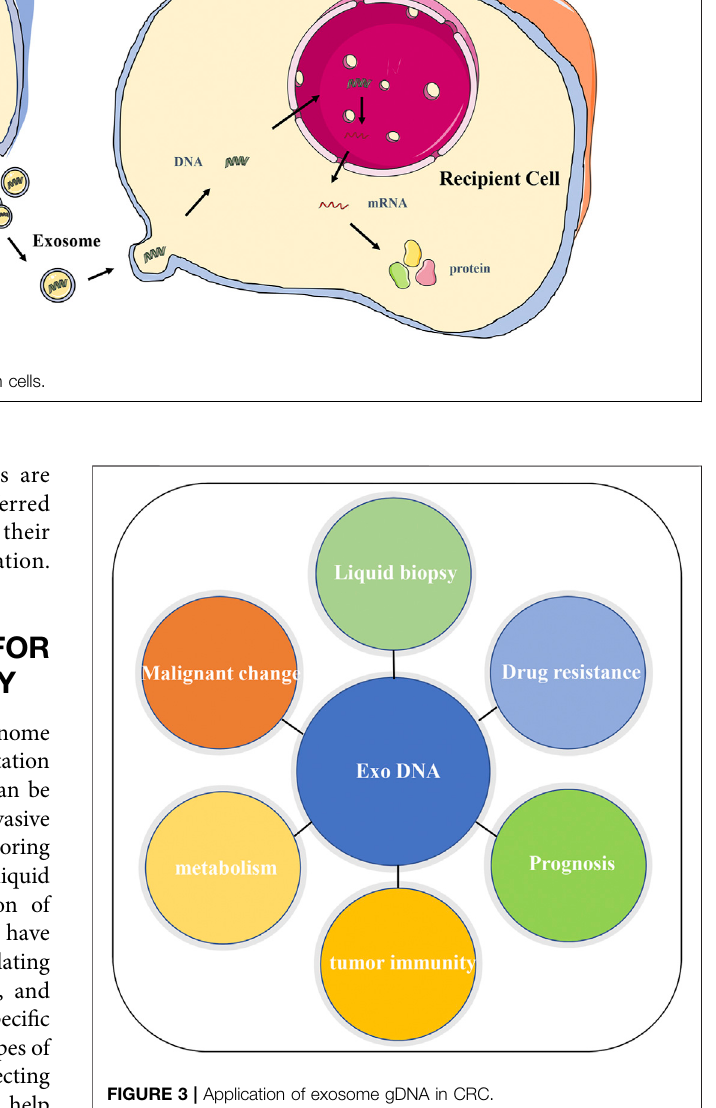
FIGURE 3 | Application of exosome gDNA in